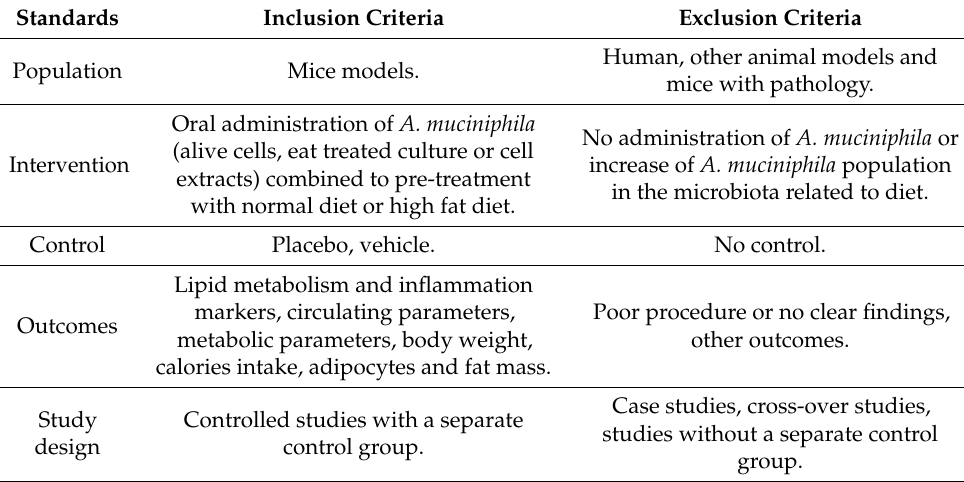
Table 1. Criteria of PICOS standards for articles